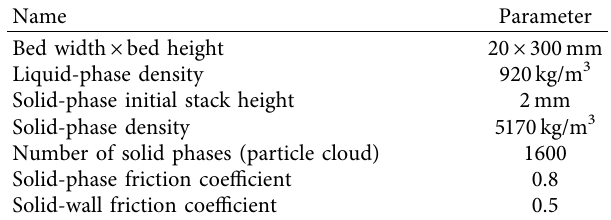
Table 1: The setting of the initial conditions of the simulation.